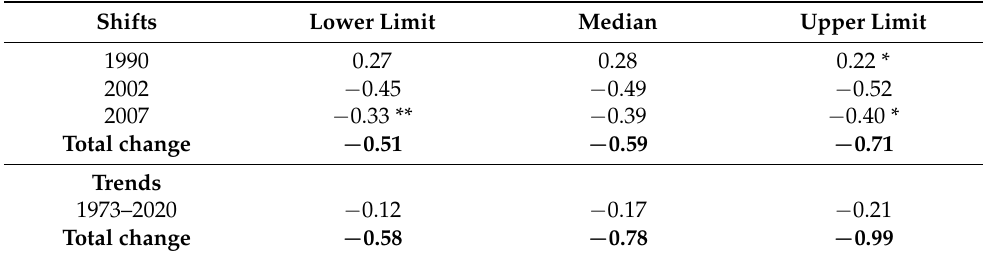
Table 3. Estimates of shifts and trends for the lower limit, median and upper limit estimate for global mean relative humidity (%) over land from the HadISDH data. Trends are % change per decade. All shifts are p < 0.01, except * p < 0.05 and ** p < 0.1. Total change for shifts is the sum of mean change between regimes and for trends is the gradient over the full period (in bold).